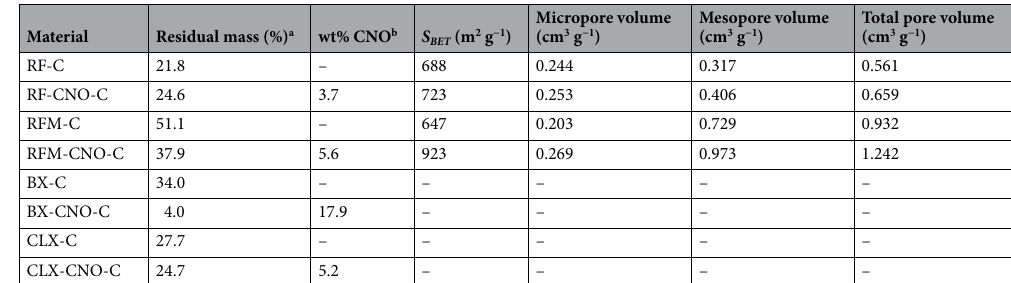
Table 1. The compositions of the composite and the textural parameters determined by adsorption– desorption of N 2 . a Residual mass (%) = ( m p : m C )·100%, where m p is mass of the material obtained by pyrolysis, m c is mass of the polymer or composite before pyrolysis. b wt% CNO = ( m CNO : m p )·100%, where m CNO is the mass of CNOs subjected to the synthesis, m p is the mass of pyrolyzed material.